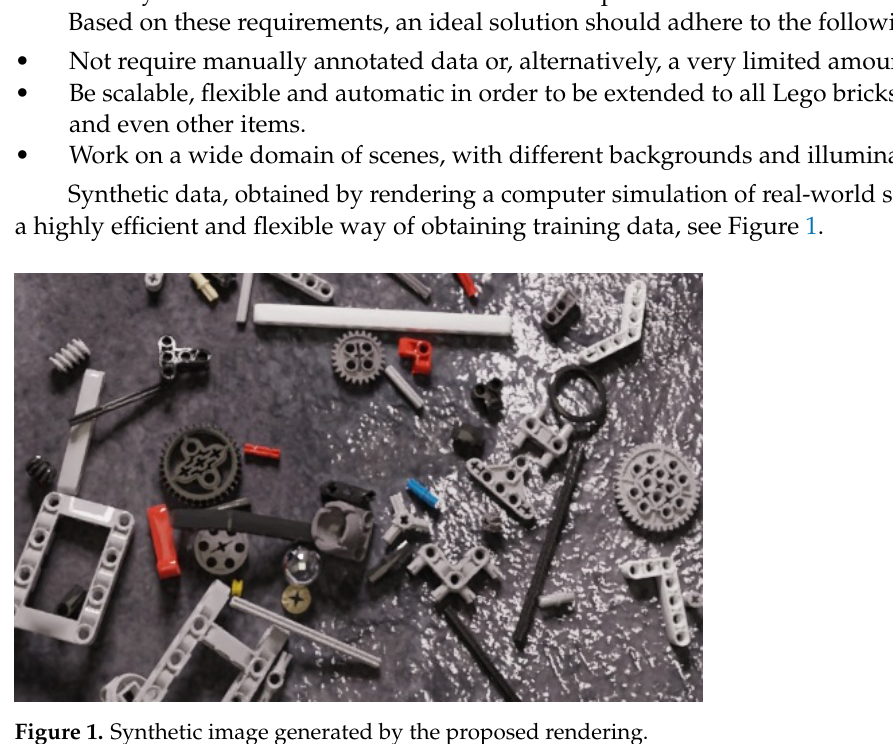
Figure 1. Synthetic image generated by the proposed